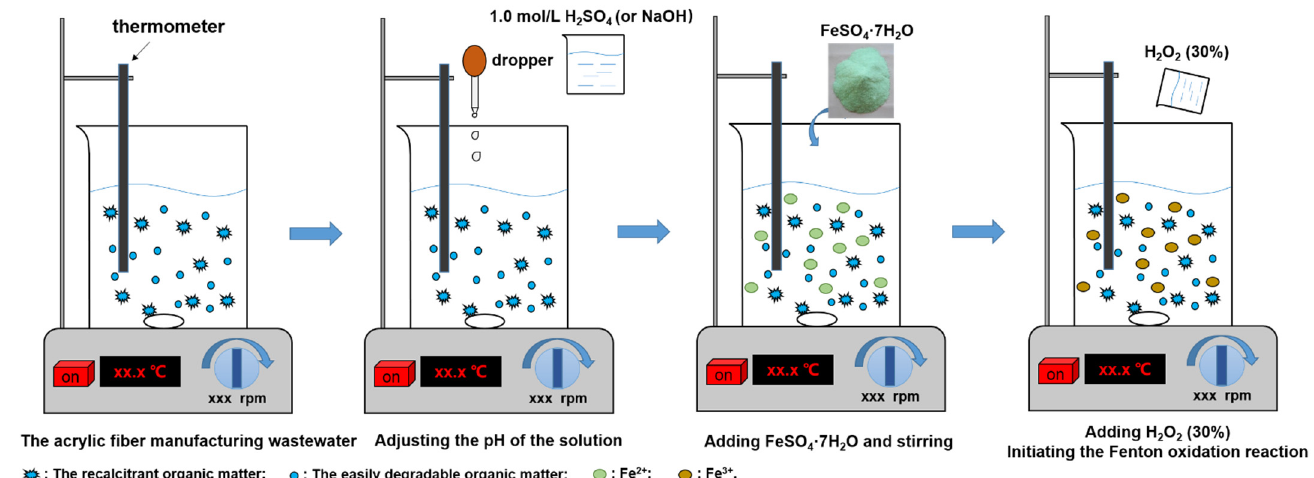
Figure 1. Fenton oxidation experiment.